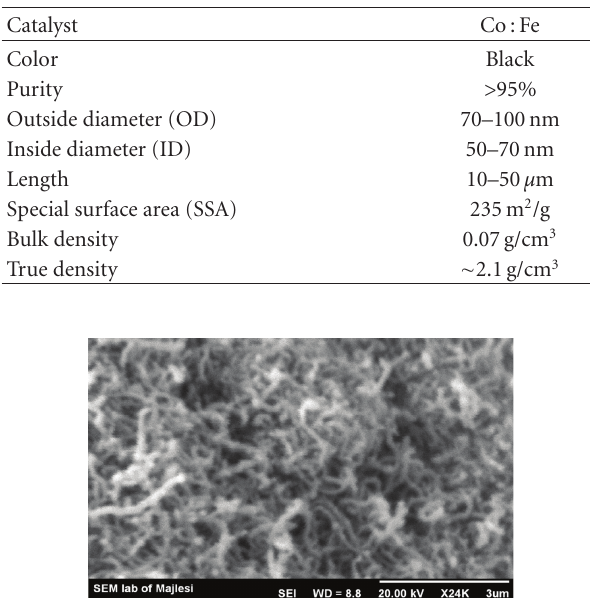
Table 1: Specification of synthesised multiwalled carbon nanotubes by chemical vapor deposition method.